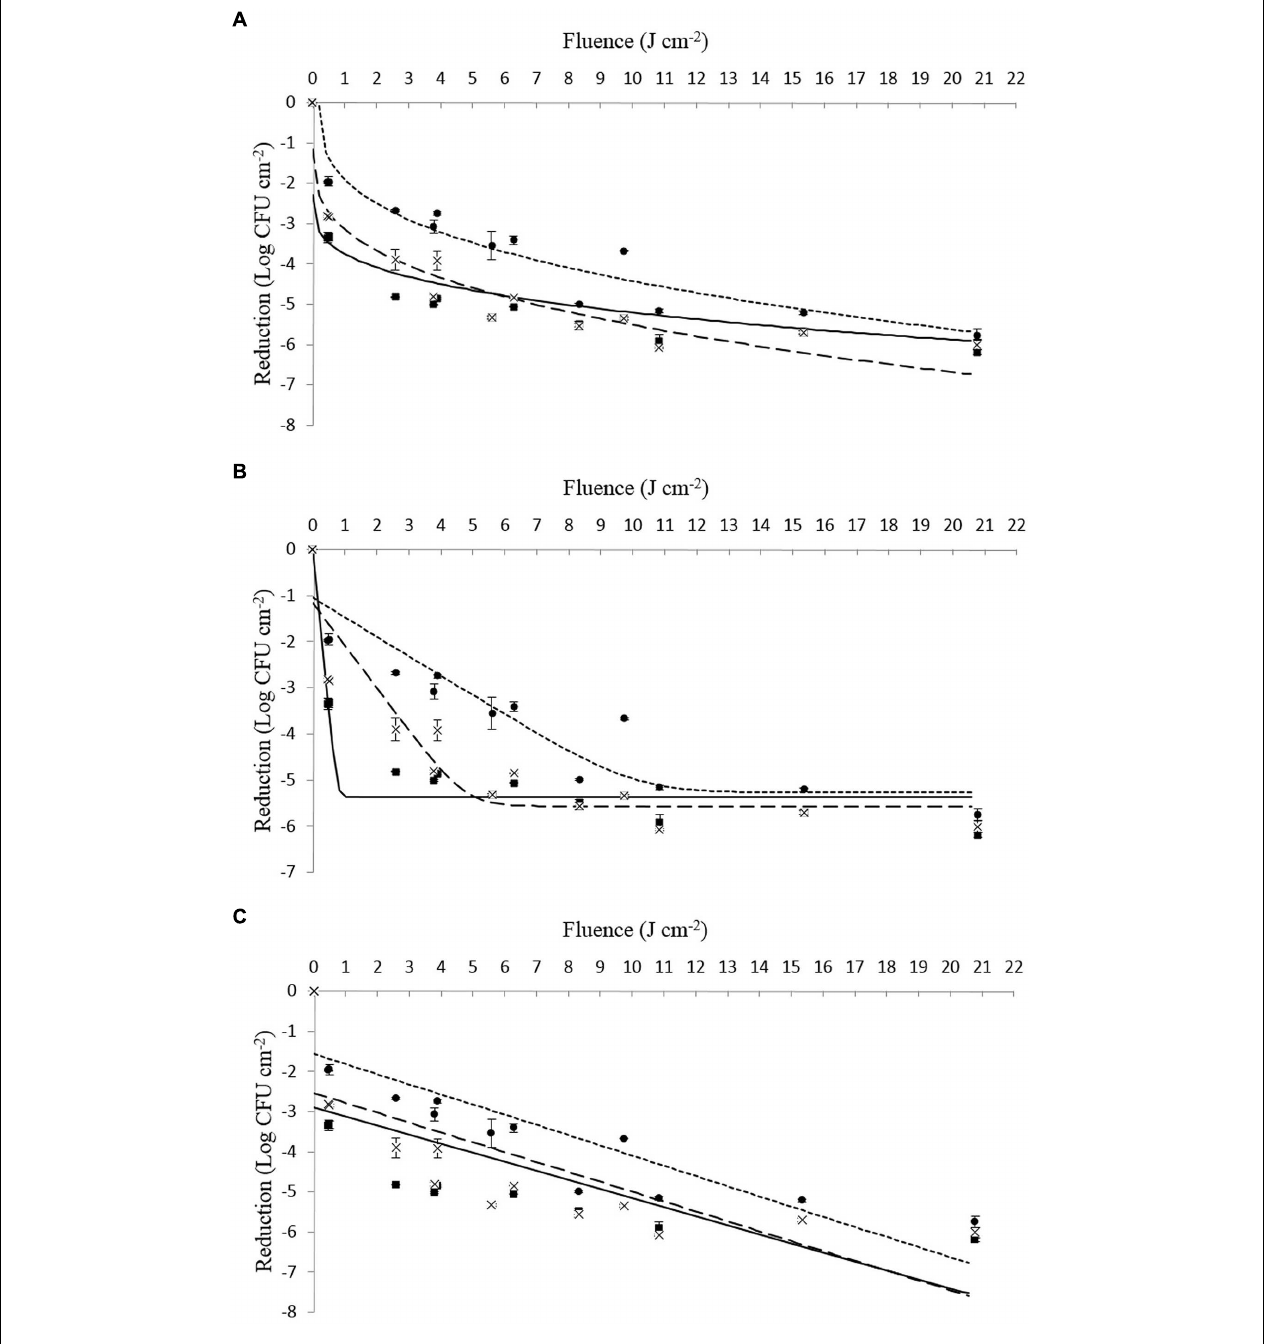
FIGURE 1 | (A–C) Survival (log CFU cm − 2 ) of viable counts of Listeria monocytogenes Li-16 inoculated on Tryptone Soya Agar supplemented with Yeast Extract when exposed to different PL treatment intensities (0.46 ± 0.16 to 20.78 ± 0.15 J cm − 2 ). The symbols represent observed means for control ( (cid:4) ), tolerant ( ) as well as tolerant and stored (x) strains. The lines represent the respective mathematical inactivation models calculated on basis of the observed values for control (solid line), tolerant (dotted line) as well as tolerant and stored strains (dashed line). (A) Weibull-type model. (B) Log – linear + tail model. (C) Log – linear